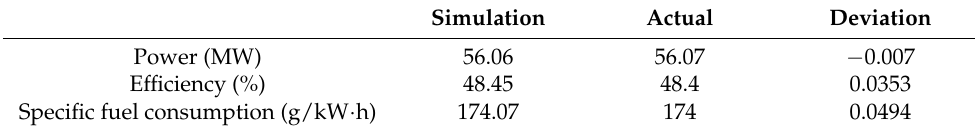
Table 4. Simulation data and actual parameters of the 2-stroke diesel engine model.